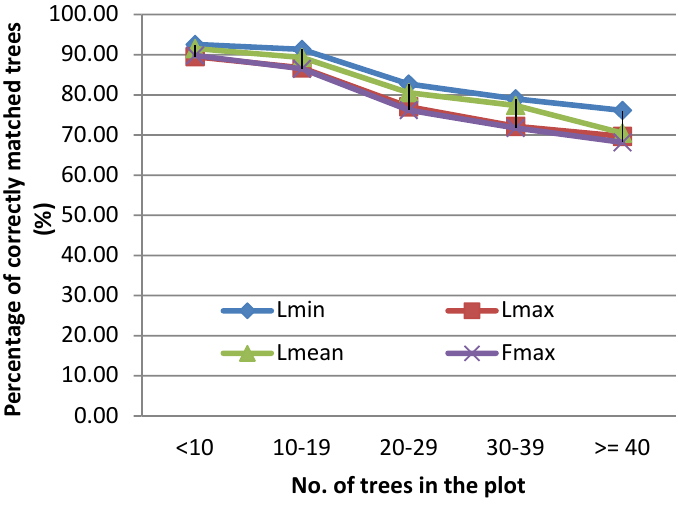
Figure 3. The percentage of correctly matched trees as a function of plot density when tested with 5,532 trees surveyed in the field. The number of trees refers to a plot with a radius of 10 m.